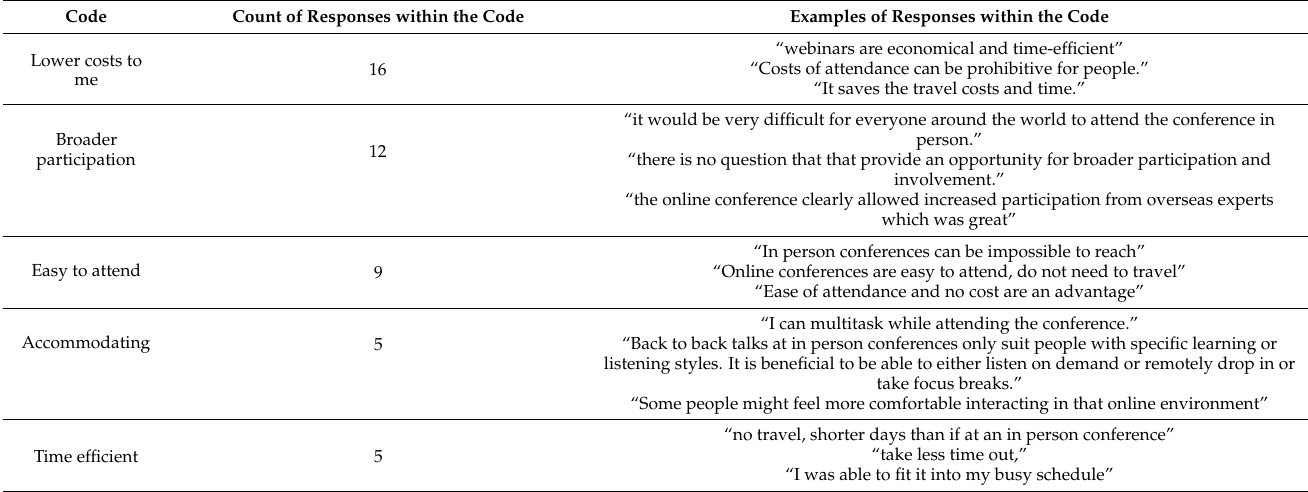
Table 1. Benefits to online conferences.